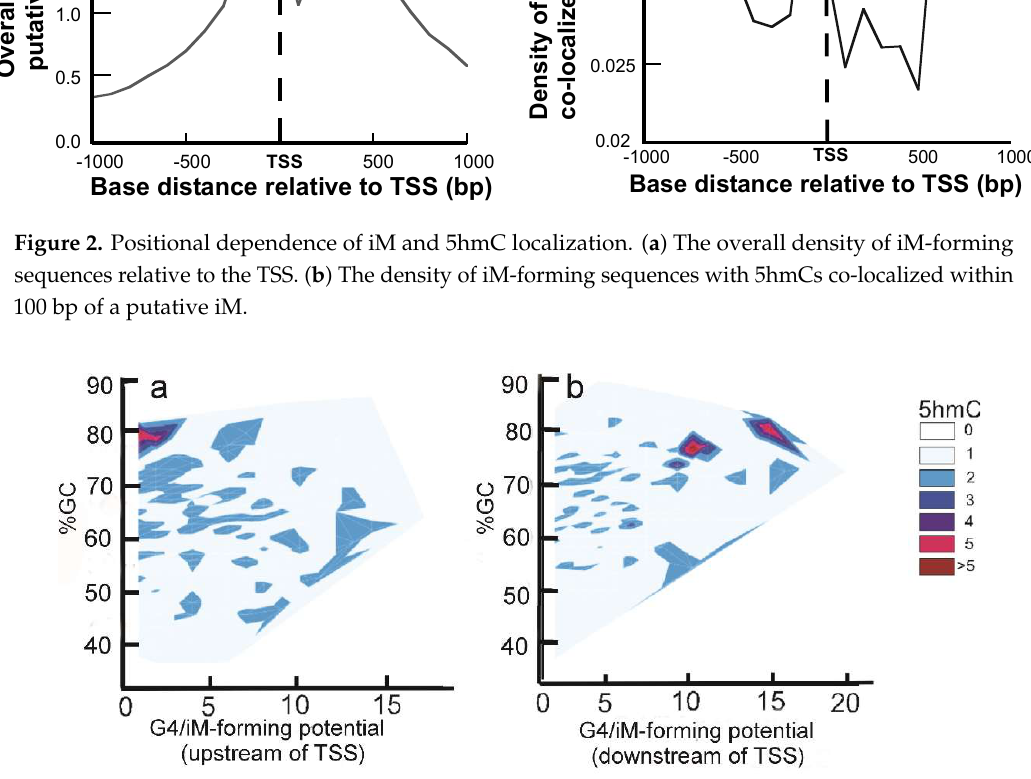
Figure 3. Relationship between iM potential (Equation (1) below) and 5hmC density. ( a ) The contour plot for the sequences upstream of the TSS shows that 5hmC enrichment is associated with sequences with low iM-forming potential. ( b ) The contour plot for the downstream sequences shows that the 5hmC enrichment is associated with sequences with high iM-forming potentials. Table 1. Correlations between number of 5hmC, iM-forming potential, and GC-content in 1 kb region upstream and downstream of TSS. The correlations were also computed for the upper and lower 95% confidence interval range. Since the correlation coefficients are very small, further analysis was done in order to assess whether or not these coefficients were significantly different from zero at a significance level of 0.05. The (*) indicates that the correlation significantly differs from being zero. 1 kb upstream of TSS Correlation Lower 95% Upper 95% Signif. Prob